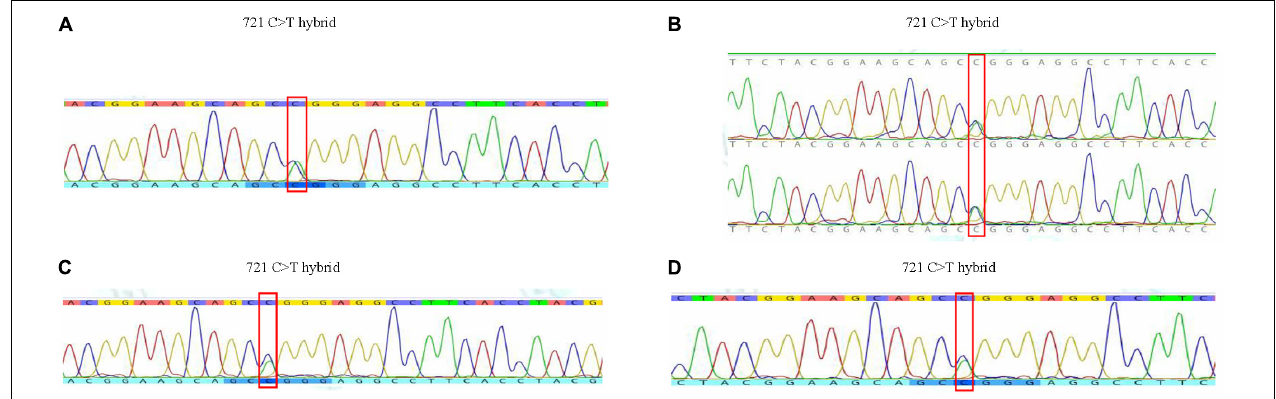
FIGURE 3 | The results of gene sequence of the family in exon 6 and 7. (A) Gene sequence of the proband. (B) Gene sequence of his daughter and son. (C) Gene sequence of his grandson 1. (D) Gene sequence of his grandson 3.